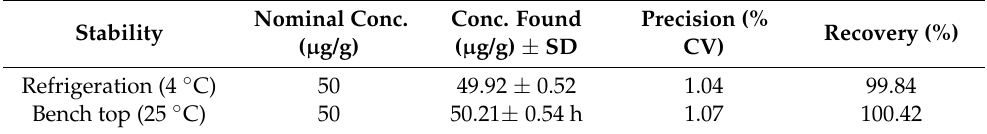
Table 8. Stability data of PTT at MCQ level at two different temperatures (mean ± SD; n =